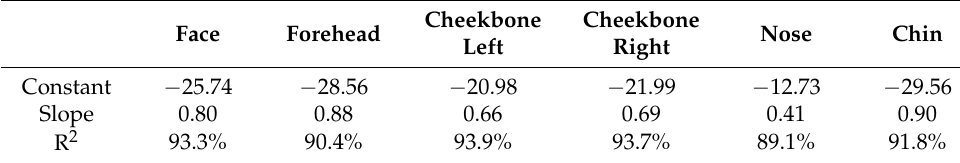
Figure 12. PMV prediction model as a function of the average face temperature.